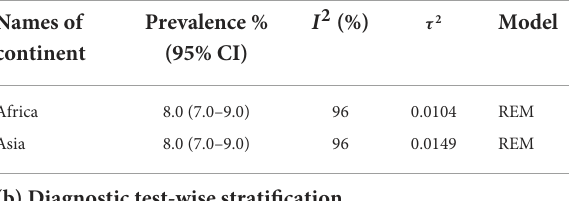
TABLE 3 Prevalence of Brucellosis stratified according to (a) Continent-wise (b) Diagnostic test-wise (c) Species-wise for sub group